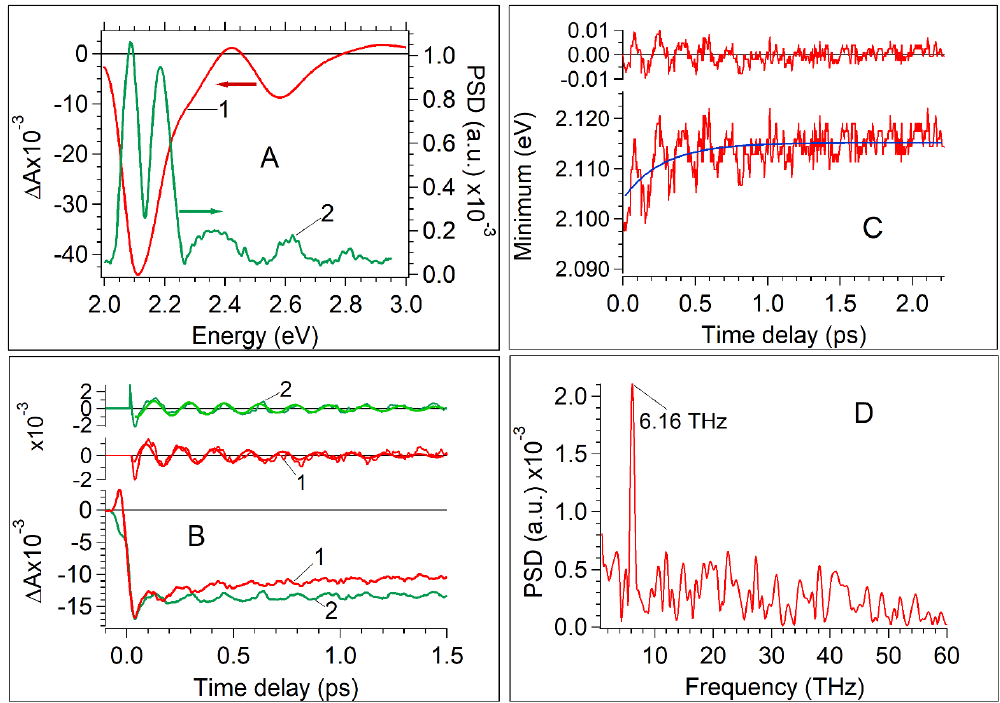
Figure 3. Oscillation components related to the coherent longitudinal-optical (LO) phonon manifestation in pump-probe transients. The data corresponds to the pump fluence of 0.064 mJ/cm 2 . ( A ) 1. Transient spectrum at time delay of 100 fs (red); 2. Amplitude of coherent LO phonon oscillation vs. probe wavelength. ( B ) Phase of coherent LO phonon oscillation: 1. Probe wavelength equals 594 nm (red); 2. Probe wavelength equals 567 nm (green). Oscillation components were revealed as residuals of the exponential fitting of relevant traces. The best fits of oscillation components by the function of exp( − t / τ D ) · sin( ω t + ϕ ) are shown by smooth solid lines (see Figure S6). ( C ) Kinetics of the minimum position of the [1S(e)-1S 3/2 (h)] bleaching band. The kinetics of the minimum shift was approximated by the exponential function ~exp( − invTau*t) with a constant of invTau = 3.6 ± 0.4 ps − 1 . The amplitude of the minimum bleaching band shift is close to 7 meV. ( D ) FFT of the oscillation components revealed as a residual shown in ( C ).